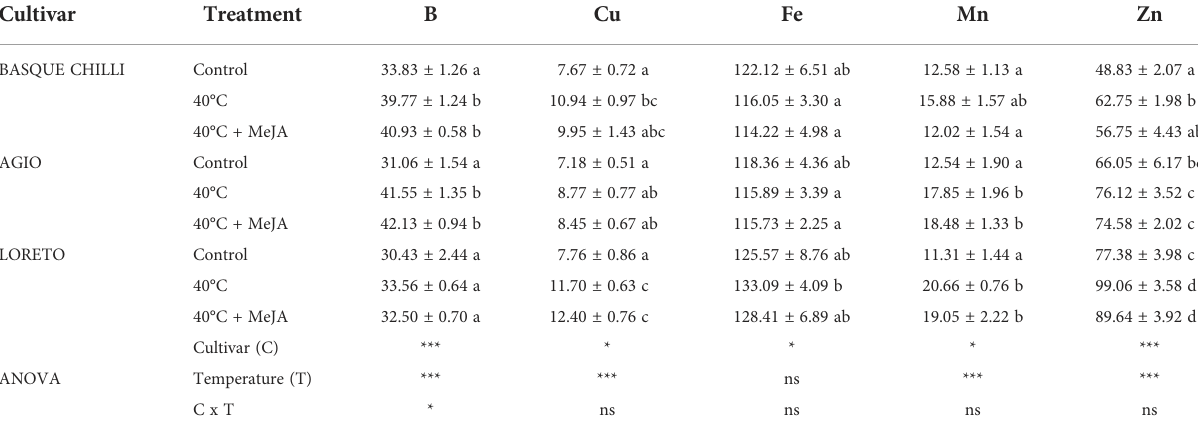
TABLE 3 Effects of heat shock and MeJA on leaf cation concentration (mg kg -1 DW) of the three pepper cultivars. Cultivar